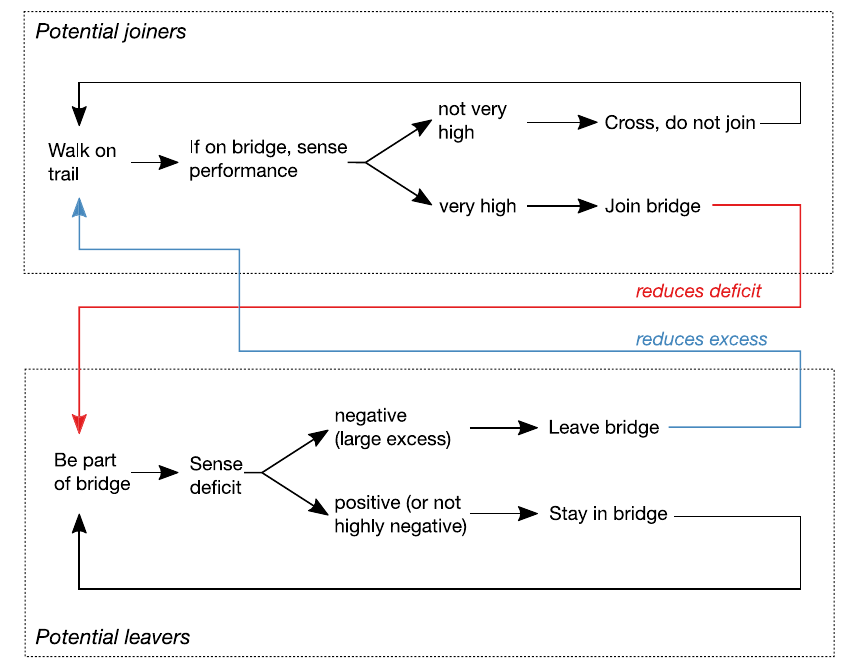
Fig. 7 Flow diagram for individual ants ’ decisions. The evidence supports separate mechanisms leading to ants choosing to join and leave bridges. High bridge performance increases the likelihood of ants joining the bridge, and the likelihood of ants leaving seems to increase when there are too many ants (large